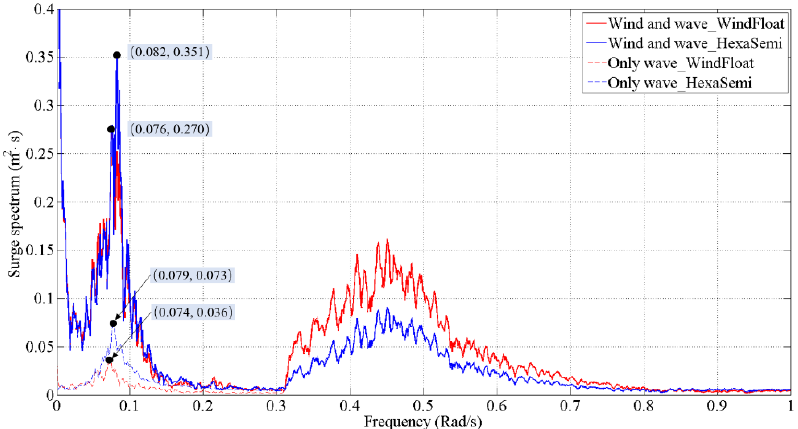
Figure 13. Comparison of surge spectrum under wind and wave induced condition and only wave induced condition.